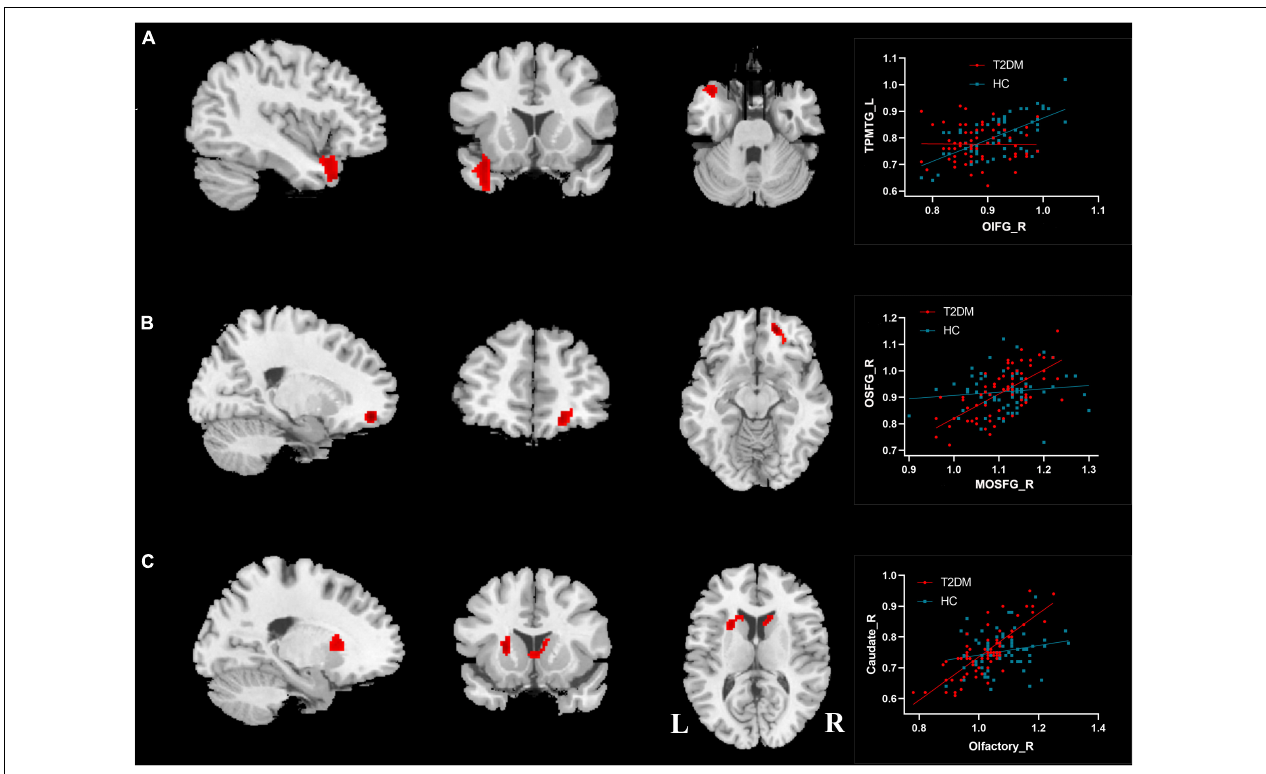
FIGURE 5 | Differences of CBF connectivity in olfactory brain regions between T2DM patients and HC group. (A) Right orbital part of the inferior frontal gyrus; (B) right medial orbital part of the superior frontal gyrus; (C) right olfactory cortex. OIFG_R, right orbital part of the inferior frontal gyrus; TPMTG_L, left temporal pole of middle temporal gyrus; MOSFG_R, right medial orbital part of the superior frontal gyrus; OSFG_R, right orbital part of the superior frontal gyrus; L, left; R,